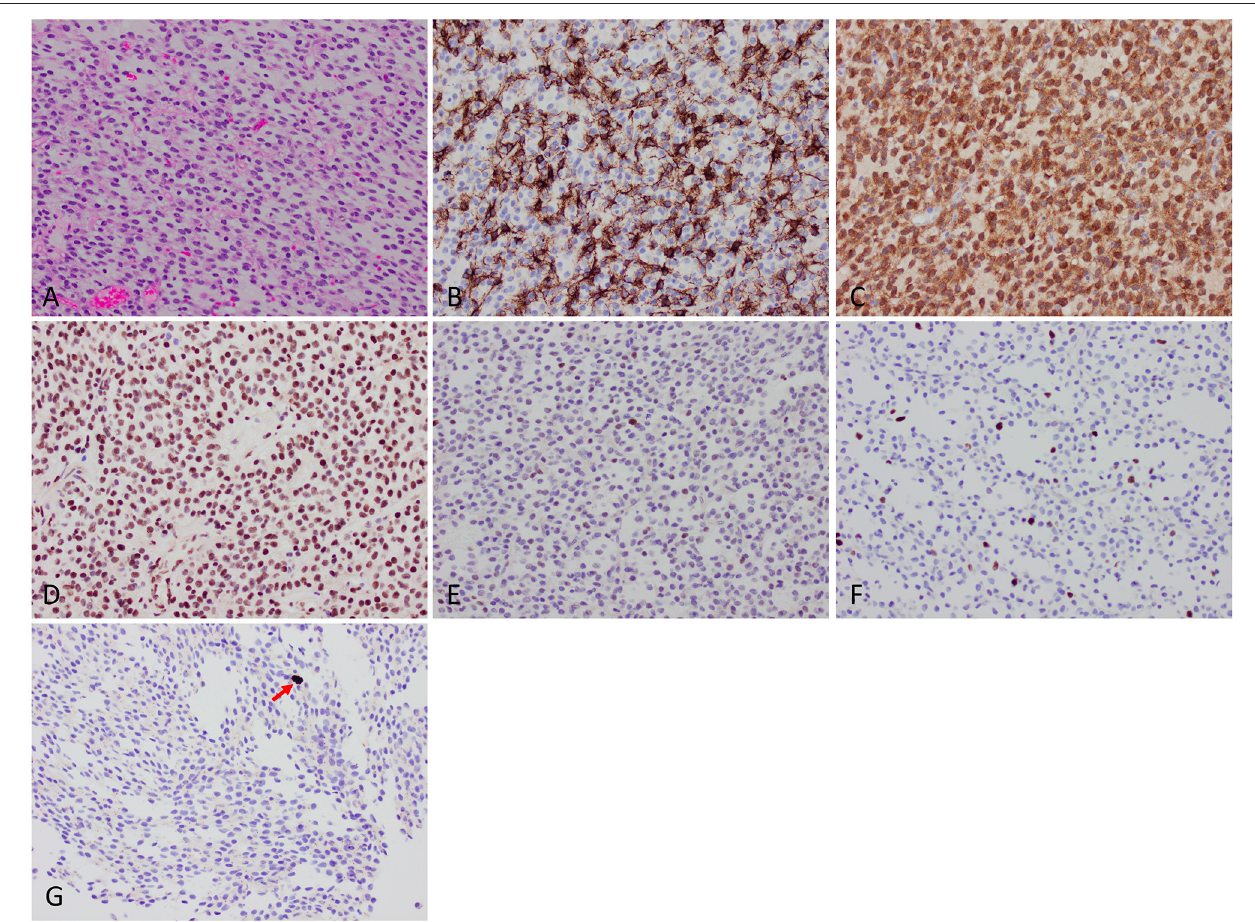
FIGURE 2 | Histologic findings. (A) Microscopic examination showed diffuse sheets of a tumor composed of relatively small cells with round-to-oval nuclei and scant-to-cleared cytoplasm. (B) GFAP was positive in a subset of tumor cells. (C) IDH1 p.R132H mutant protein immunohistochemistry was strongly positive. (D) ATRX protein wildtype expression was retained. (E) Weak expression of p53 protein. (F) Low Ki67 labeling index of 4.8%. (G) Mitotic activity (arrow) was quantified at a maximum of 2 per 10 high-power fields using phosphohistone H3 (pHH3) immunostaining.